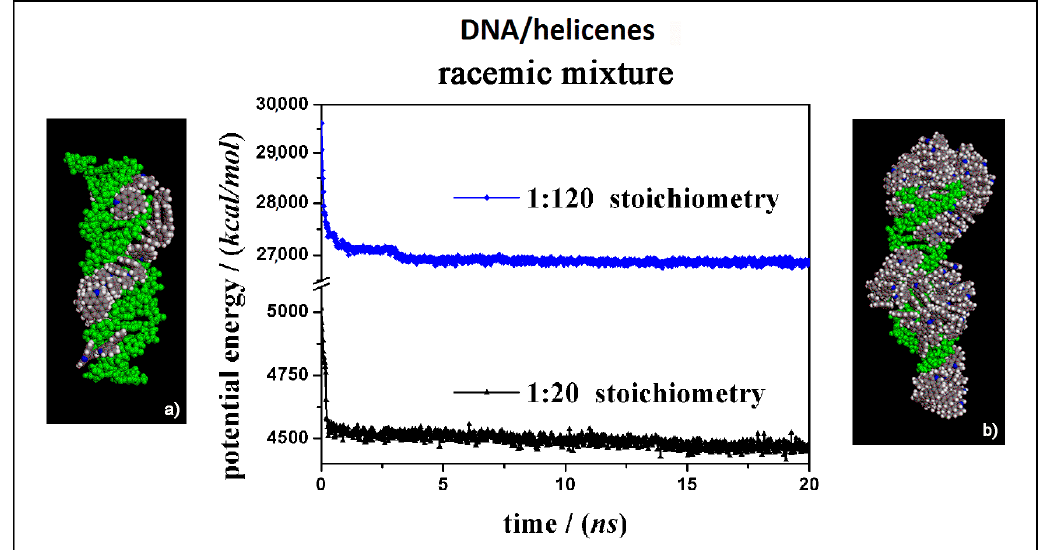
Figure 9. Optimized geometries of ( M )-HA and ( P )-HA in a racemic mixtures at low concentration on the left ( a ) and at high concentration on the right ( b ) after energy minimization of the conformation assumed by the system at the end of the MD run considering racemic mixtures in 1:20 and 1:120 stoichiometry respectively. In the central panel the potential energy calculated during MD run lasting 20 ns for racemic mixture in 1:20 stoichiometry (black symbols) and in 1:120 stoichiometry (blue symbols) respectively. The color code is the same as in Figure 5.